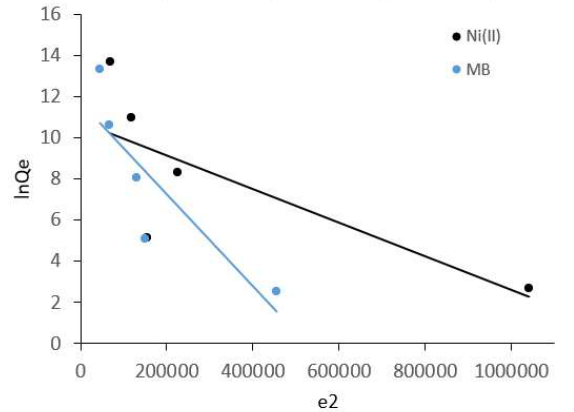
Fig.11. D-R adsorption isotherm for removal of Ni(II) ions and MB onto natural clay